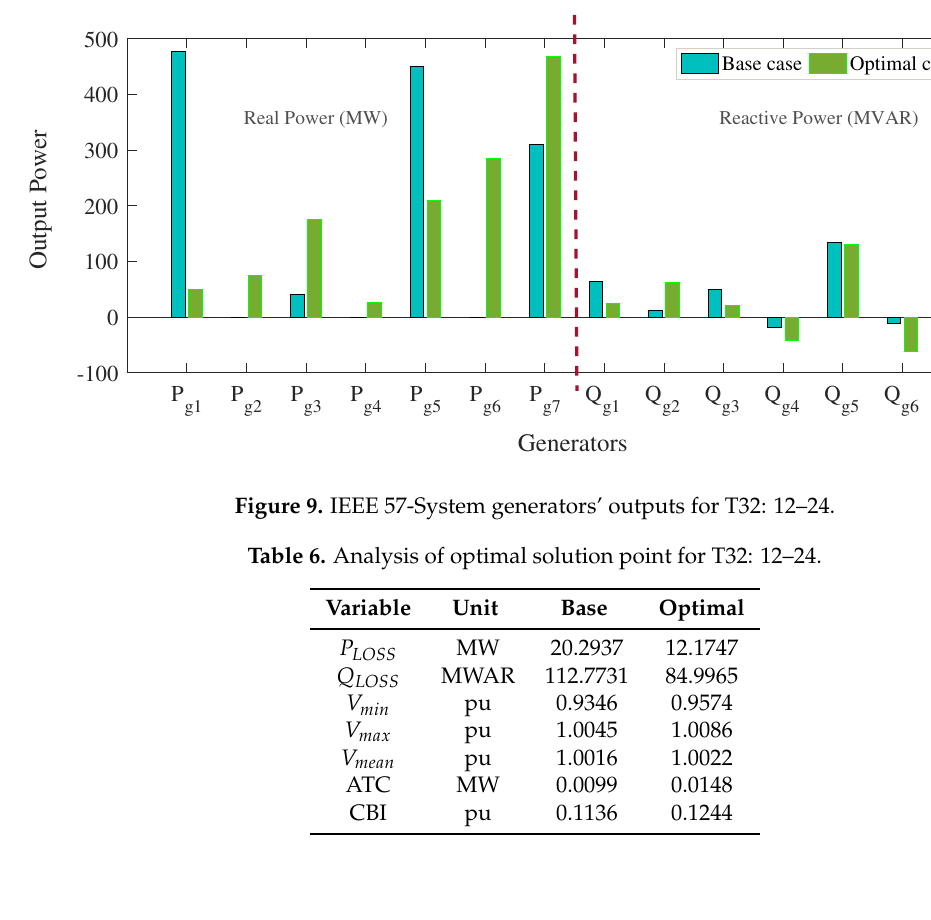
Figure 8. IEEE 57-Convergence characteristics for T32: 12–24.